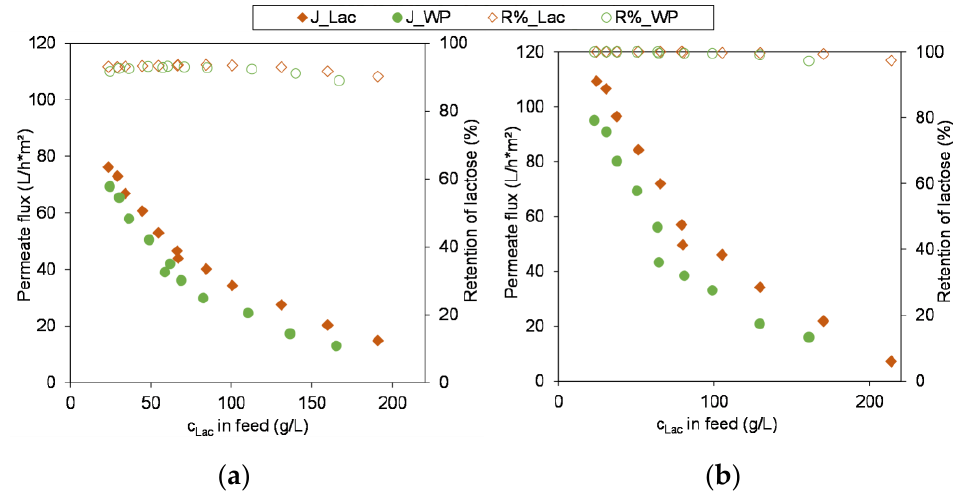
Figure 6. Resulting permeate flux (J) and retention (R%) of lactose during concentration of lactose model solution (Lac) versus whey permeate (WP); ( a ) XN45 (20 °C & 3 MPa); ( b ) NFS (45 °C & 2 MPa). Operation parameters summarized in Table 3.